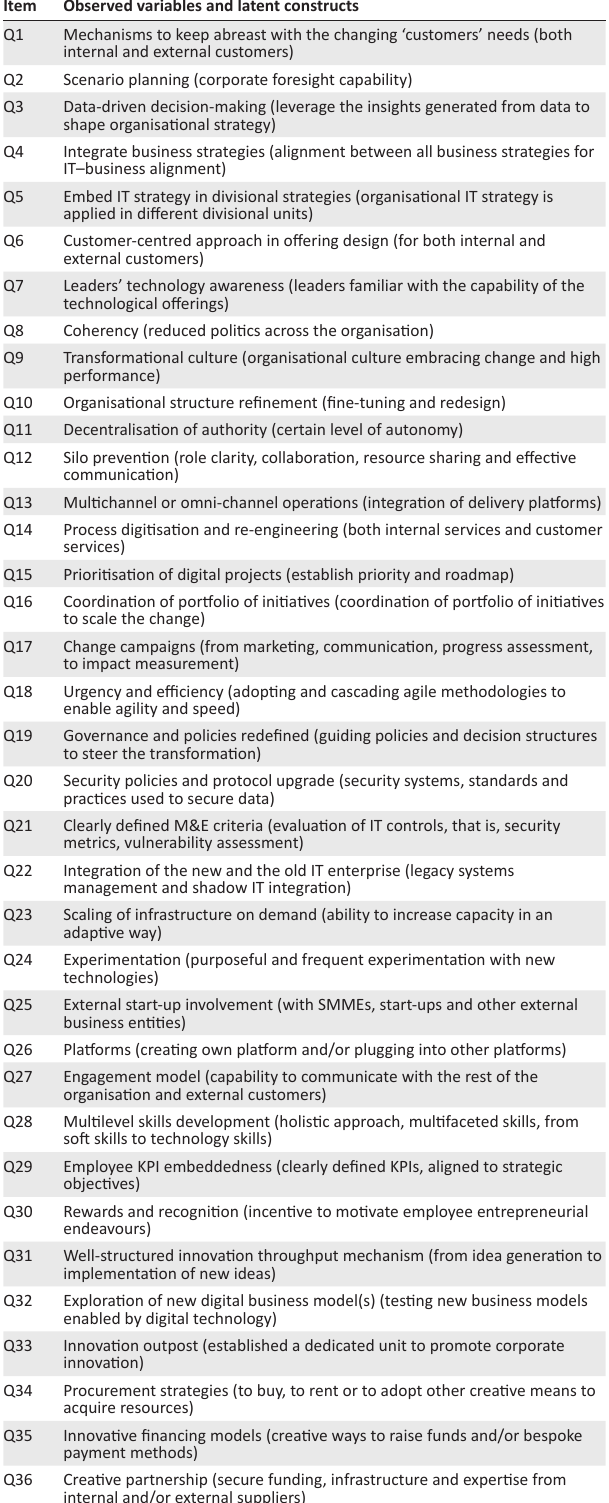
TABLE 2: Extract of research questionnaire.